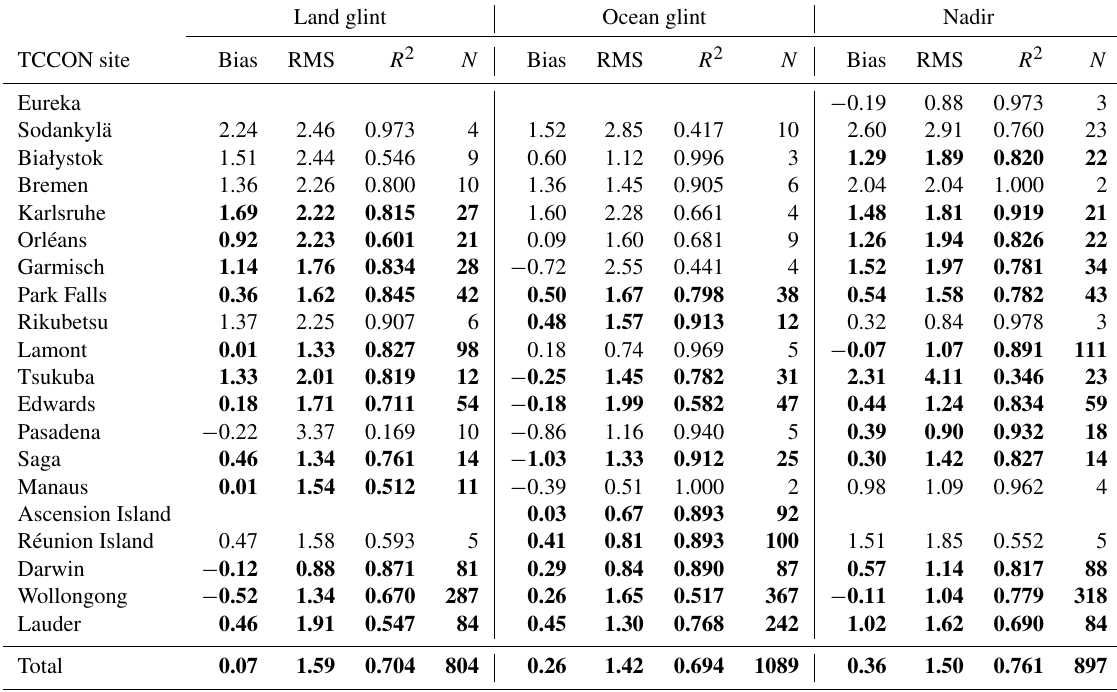
Table 4. Glint and nadir statistics for data filtered using Warn Levels ≤ 15 and the xco2_quality_flag = 0. The median bias (OCO- 2 − TCCON) and its RMS, R 2 and number of daily median comparison points, or “coincidences” ( N ) are listed below for each TCCON station. If the number of coincidences is larger than 10, the results are marked in bold font. The “Total” row is calculated by considering all the coincidences in the table independently. In general, the RMS values are equal to or larger than those in Table 3 despite the fact that the number of coincidences is larger.